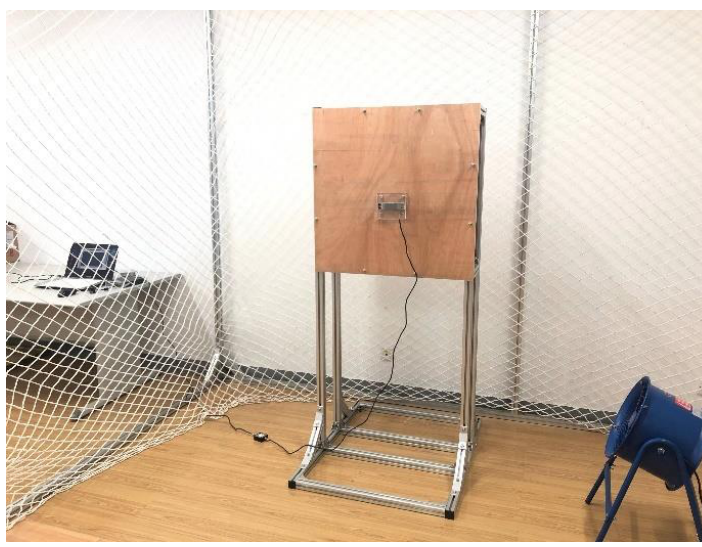
Figure 18. The pressure information acquisition system.